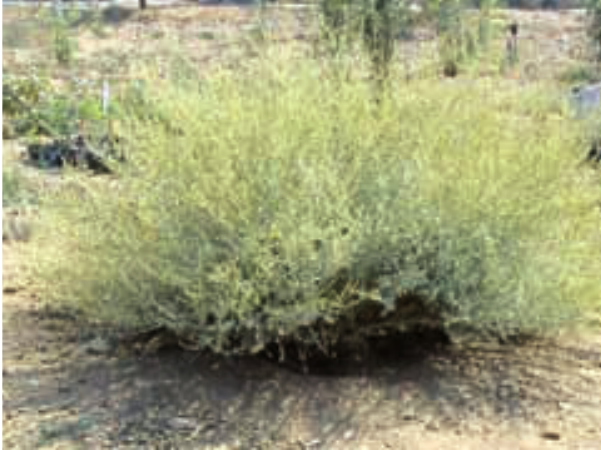
Fig. 6. In vitro propagated Atriplex halimus (1 year old) under field